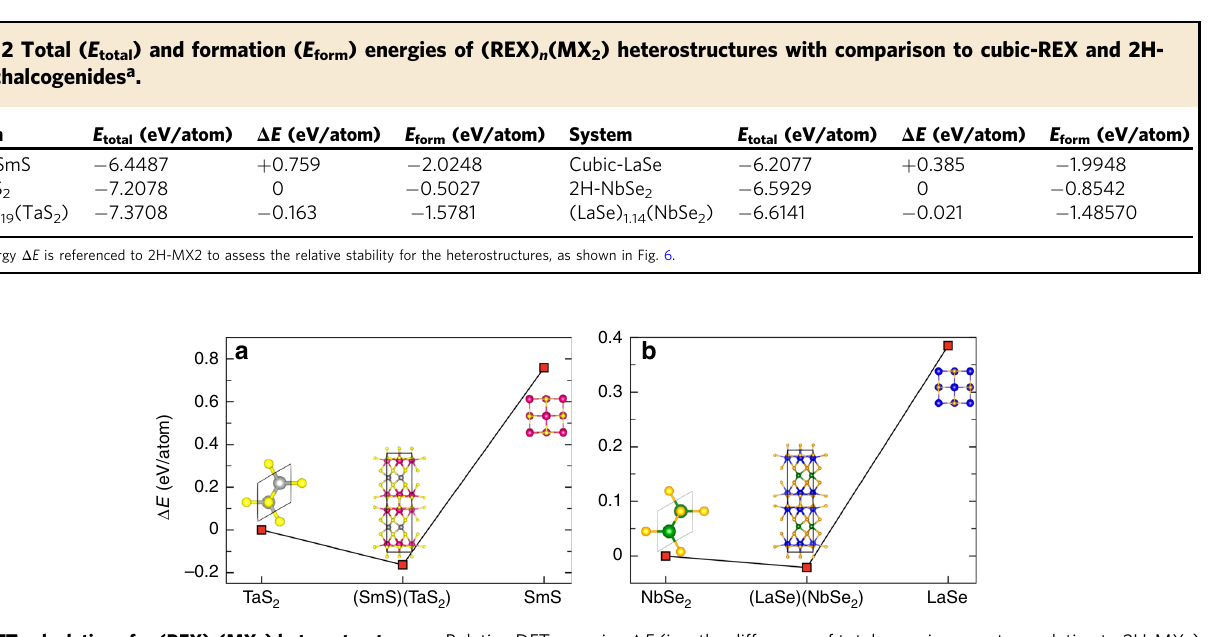
Fig. 6 DFT calculations for (REX) n (MX 2 ) heterostructures. a Relative DFT energies Δ E (i.e., the difference of total energies per atom relative to 2H-MX 2 ) of (SmS) n (TaS 2 ), n = 1.19 and of b (LaSe) n (NbSe 2 ), n = 1.14 mis fi t compounds compared to single-phase cubic-REX [SmS, LaSe] and 2H-MX 2 [TaS 2 , NbSe 2 ] building